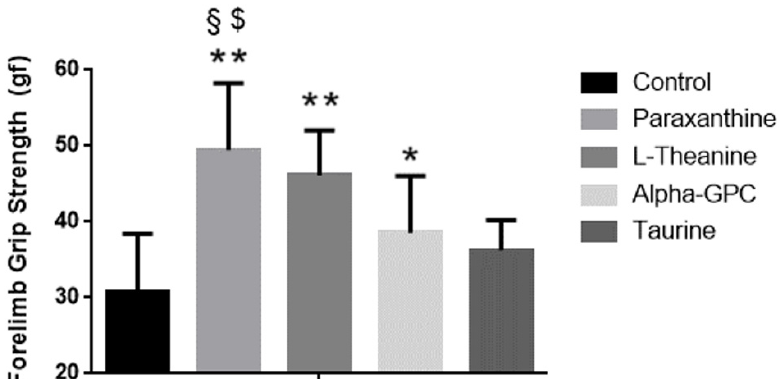
Figure 1. Changes in forelimb grip strength in mice. Data is presented as means ± SD ( n = 8 in each group). Unit of measures is grams of force. * * = p < 0.001 vs. control, * = p < 0.05 vs. control, § = p < 0.05 vs. alpha-GPC, $ = p < 0.01 vs. taurine. Baseline treadmill performance was not different between groups (control 267.1 ± 29.3 cm, paraxanthine 255.3 ± 30.7 cm, L-Theanine 265.4 ± 32.9 cm, alpha-GPC 248.6 ± 42.2 cm, taurine 256.9 ± 29.3 cm, p = 0.79). Paraxanthine supplementation for 28 days resulted